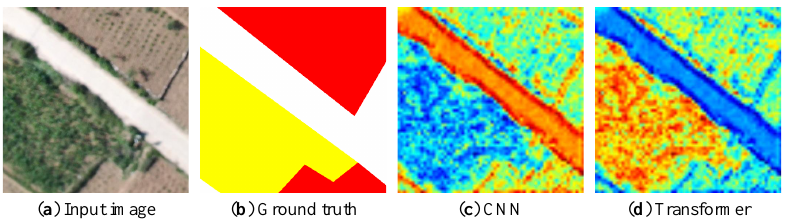
Figure 8. Feature weight maps of the CNN and Transformer. ( a ) is the crop remote sensing image; ( b ) is the true value; ( c , d ) are the weight maps of the CNN and Transformer, respectively.